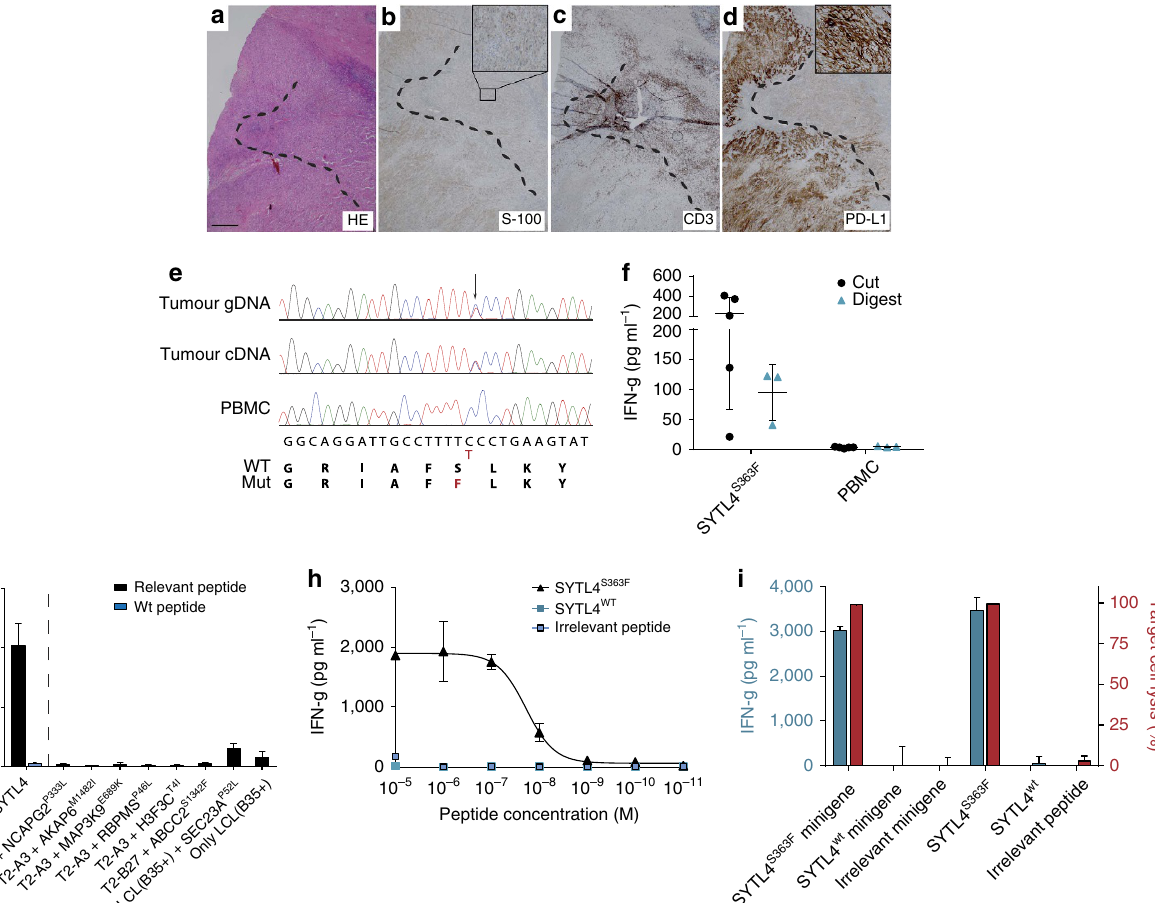
Figure 6 | In-depth characterization of tumour and peptide-reactivity of SYTL4-specific Tcells derived from PBMC as well as TILs. HE ( a ) staining of a lung metastasis after metastasectomy (01/2016, day 796) as well as immunohistochemistry stainings with anti-S100 ( b ), anti-CD3 ( c ) and anti-PD-L1 ( d ); ( b , d ) Inset: (cid:3) 20 magnification. Scale bar, 500 m m. Sanger sequencing of the mutated region from SYTL4 in processed tumour material from day 796 using either isolated genomic DNA (gDNA) or coding DNA (cDNA) as template ( e ). IFN-g secretion of T-cell line PBMC-SYTL4-740 on co-culture with cut (5 wells) or digested (3 wells) fresh tumour material for 36h ( f ). Non-stimulated PBMC from Mel15 served as controls. Horizontal lines and error bars show mean and s.d., respectively. Co-incubation of in-vitro expanded TIL with target cells pulsed with mutated peptide ligands ( g ). SYTL4 wt served as negative control, analysis was performed using triplicates and depicted as mean ± s.d. Reactivity of the TIL-derived T-cell clone TIL-SYTL4clone1 against T2-B27 target cells pulsed with titrated concentrations of mutated, wt or irrelevant peptide ( h ). Co-culture of TIL-SYTL4clone1 with LCL1 either peptide pulsed or transduced with mutated or wt minigenes ( i ) with results shown as mean of duplicates. Amount of IFN-g secretion was assessed in supernatants (left Y -axis) and amount of target cell lysis was analysed by FACS-based acquisition of total number of vital target cells in relation to untreated LCL (right Y -axis); coincubation was performed in triplicates and results are shown as mean and